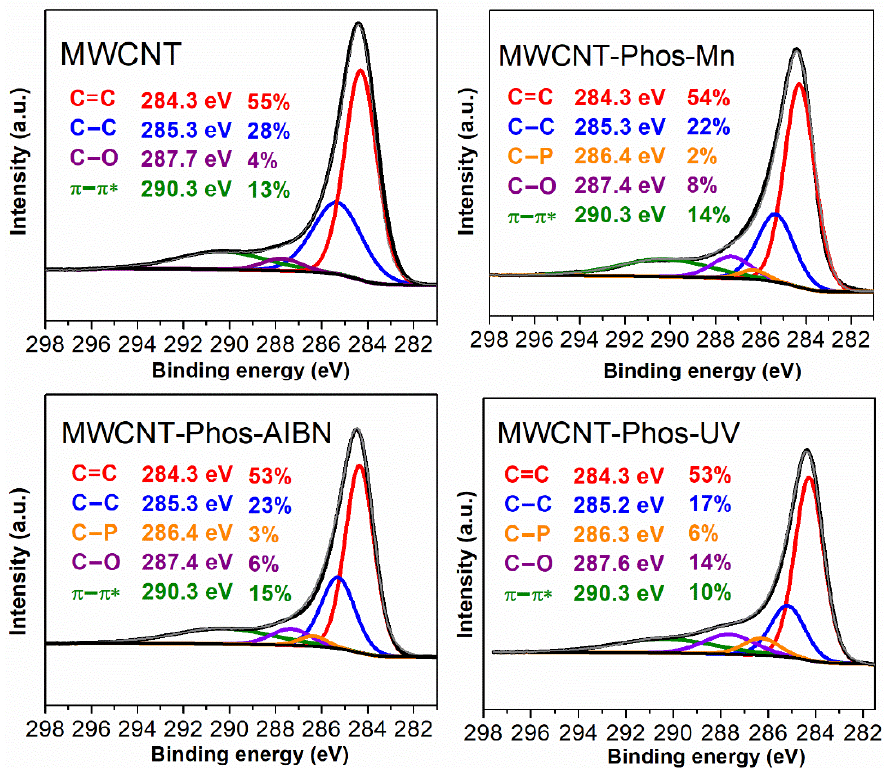
Figure 6. High resolution XPS spectra of C1s with peak positions and calculated atomic percent-